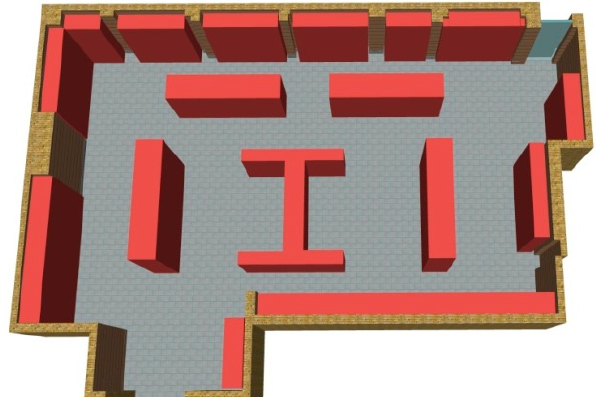
Figure 1. Simulation of the layout of shelves in a supermarket.